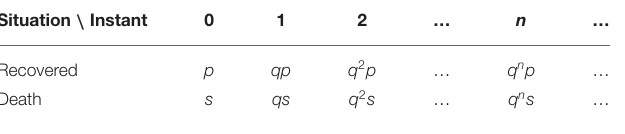
TABLE 1 | Probabilistic